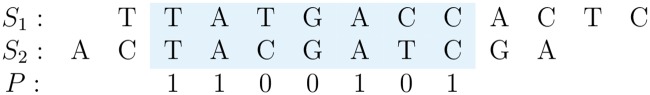
Spaced-word match between two DNA sequences S1 and S2 at (2,3) with respect to a pattern P = 1100101 representing match positions (‘1’) and don’t-care positions (‘0’).The same spaced word TA**A*C occurs at position 2 in S1 and at position 3 in S2.